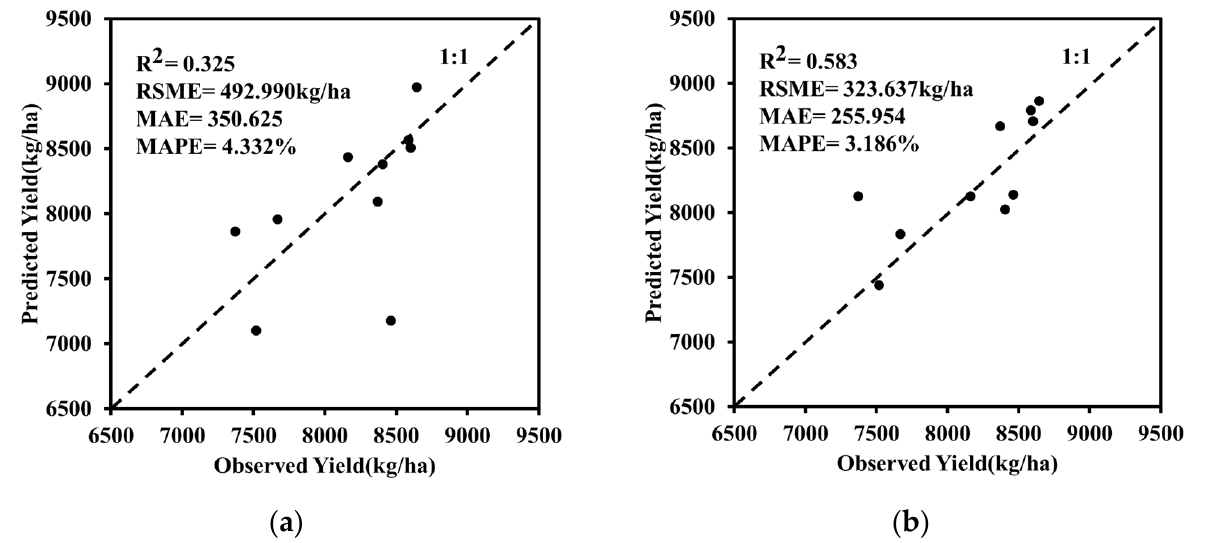
Figure 9. The R 2 , RSME, MAE, and MAPE for the relationship between the observed and predicted yields based on the ( a ) unweighted and ( b ) weighted optimal VI groups. The dashed line is the 1:1 line.